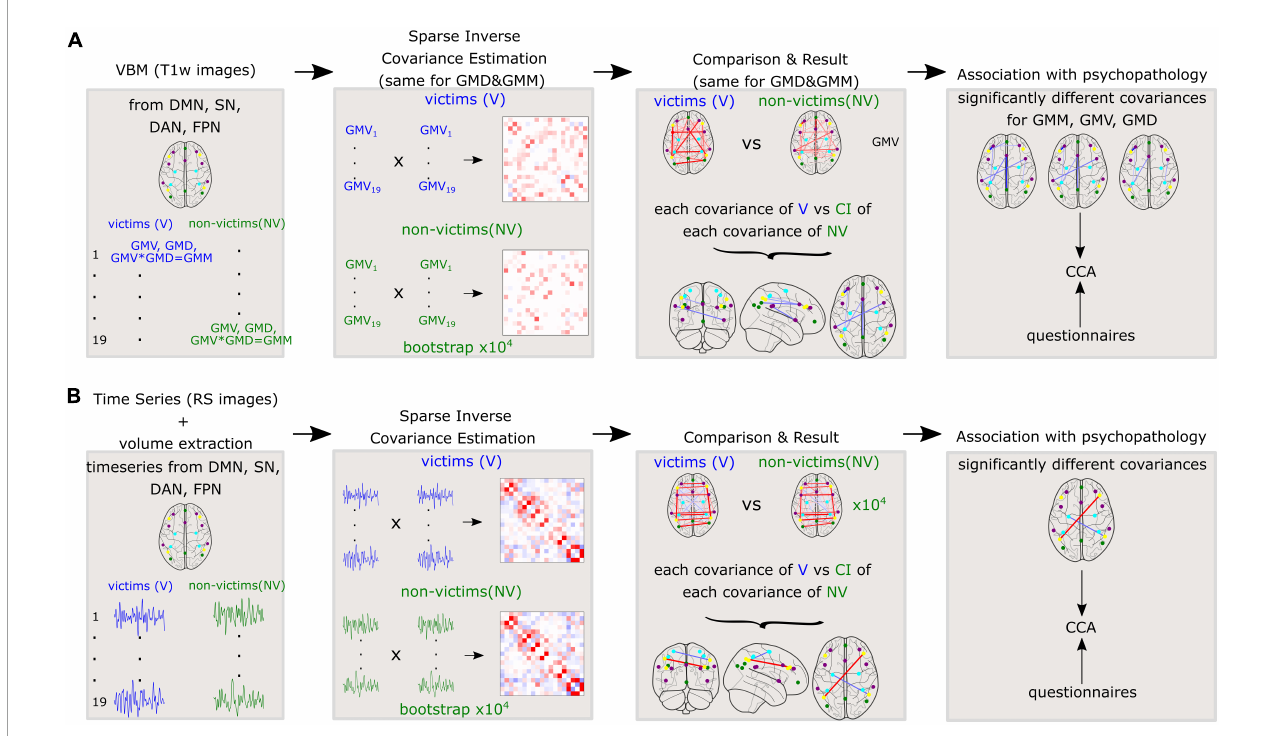
FIGURE2 Methods applied to the whole cohort for (A) : Variables derived from gray matter (GM) such as gray matter volumes (GMV), gray matter densities (GMD), and gray matter masses (GMM) and (B) : Time series of resting state fMRI. Sparse inverse covariance was estimated between the 19 nodes on the group level. Further, the covariances were compared between V and NV. The differences in covariances were correlated with the